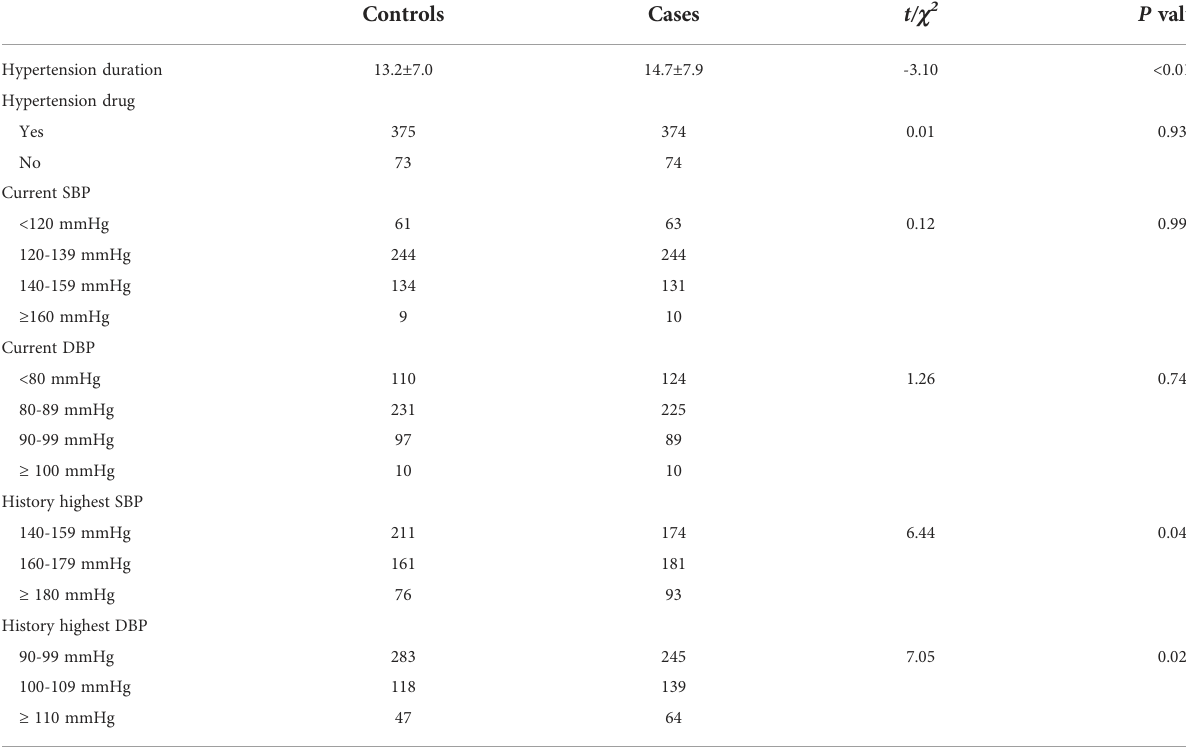
TABLE 2 The hypertensive characteristics of cases (T2DM and hypertension) and controls (hypertension).